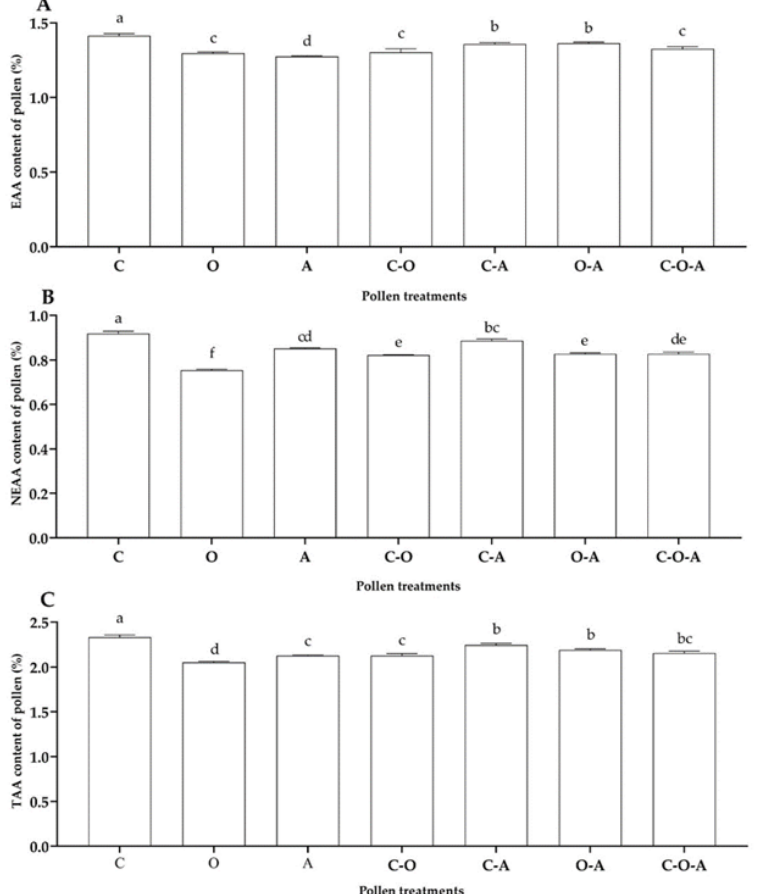
Figure 1. Contents of amino acids in the pollen treatments: ( A ) essential amino acids (EAA); ( B ) non-essential amino acids (NEAA); ( C ) total amino acids (TAA). C: camellia pollen mix; O: oilseed rape pollen mix; A: apricot pollen mix; C–O: camellia–oilseed rape pollen mix; C–A: camel- lia–apricot pollen mix; O–A: oilseed rape–apricot pollen mix; C–O–A: camellia–oilseed rape–apricot pollen mix. The data having same letter represents with no differences among treat- ments ( p > 0.05), and the data having different letter represents with have significant differences among treatments ( p < 0.05).